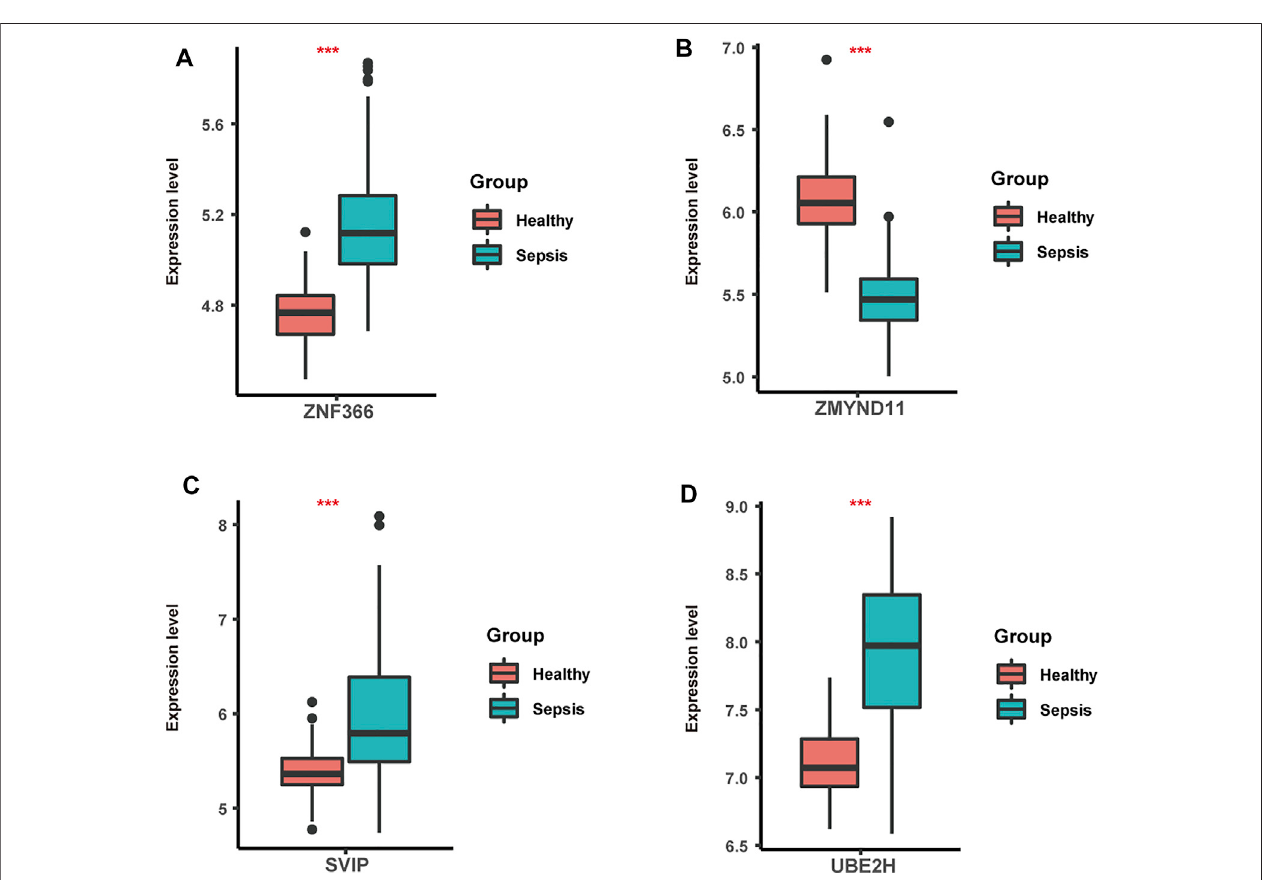
FIGURE 6 | The expression levels of ZNF366 (A) , ZMYND11 (B) , SVIP (C) and UBE2H (D) in sepsis and healthy samples from GSE134347. These four hub genes were all differentially expressed. *** p < 0.001.